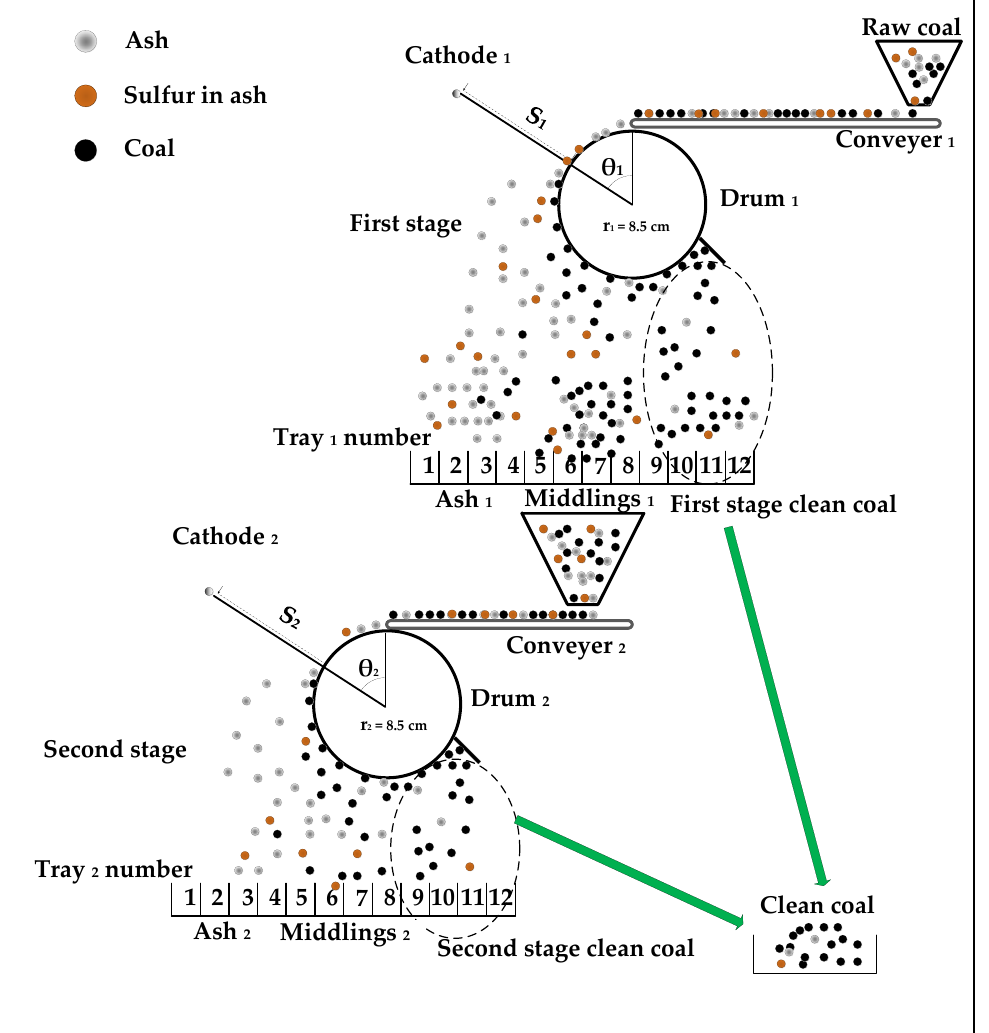
Figure 1. Schematic illustration of dry coal cleaning system with two-stage corona electrostatic processes for high-sulfur low-grade fine coals.